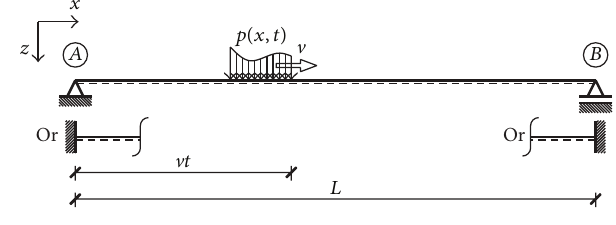
Figure 2: A single-span beam subjected to a moving load.